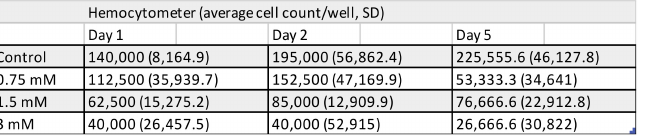
Figure 1. Number of viable pulp cells at various time-points of the 5-day exposure to 0.75, 1.5,